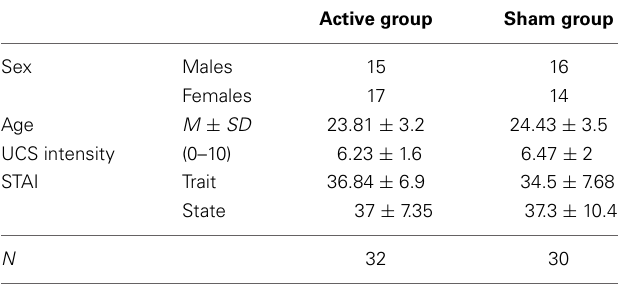
Table 2 | Subsample of successful conditioned volunteers for data analysis of the subjective ratings.